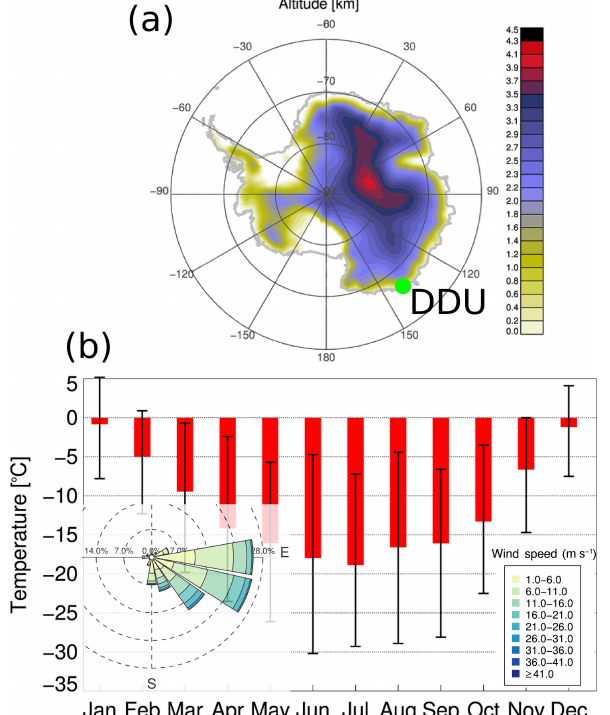
Figure 1. (a) Map of Antarctica with digital elevation model (do- main south of 60 ◦ S). A green filled circle locates the station Dumont d’Urville (DDU). (b) Temperature statistics in Dumont d’Urville, based on data collected at 1min time resolution in the pe- riod 2011–2015. The red bars locate the mean value and the black error bars are used to highlight the 1 and 99% quantiles. Overlayed: wind rose (origin and intensity) statistics.